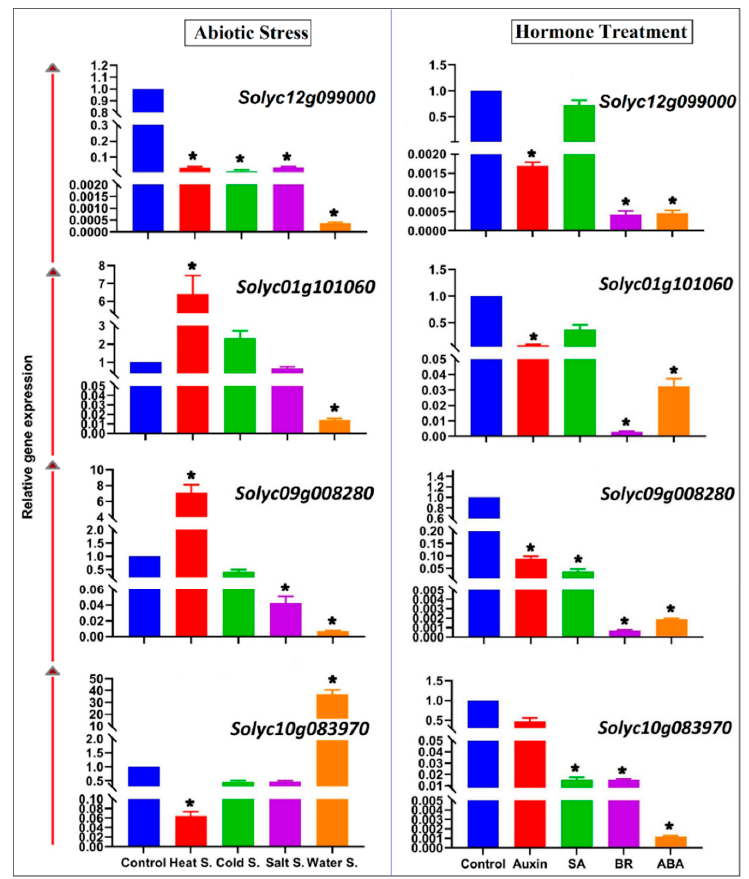
Figure 8. Expression patterns of SAMS genes under abiotic stress and hormone treatments. An asterisk above a bar indicates a significant difference between the experimental treatments and control treatment (according to Student’s t -test).